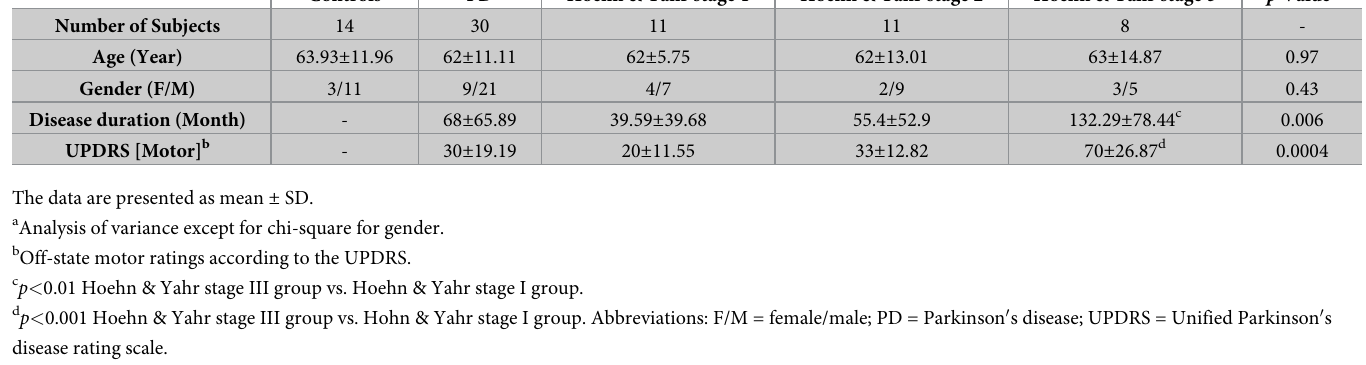
Table 1. The demographic and clinical data collected from 30 Parkinson’s patients and 14 healthy controls. Controls PD Hoehn & Yahr stage 1 Hoehn & Yahr stage 2 Hoehn & Yahr stage 3 p Value a